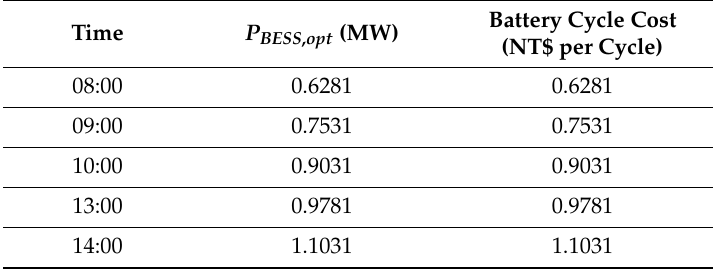
Table 7. The cost analysis and required capacity of the BESS methods.